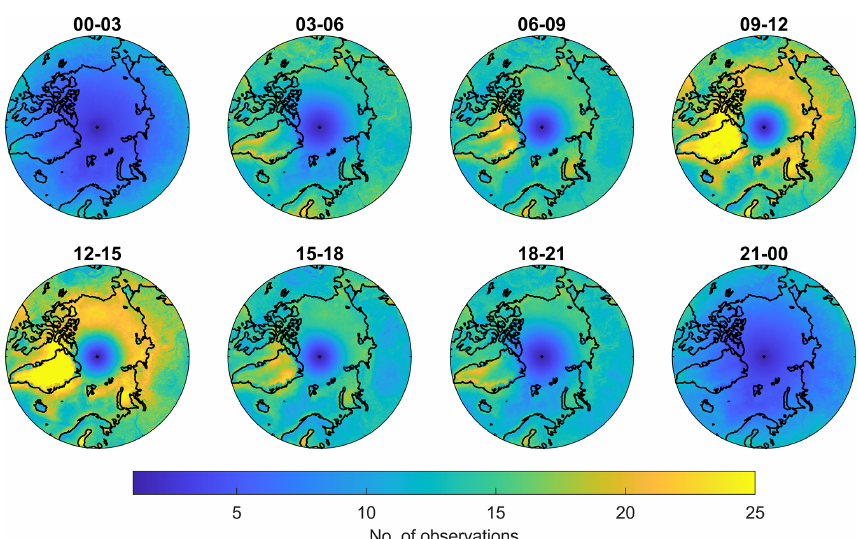
Figure 3. Mean number of observations per day in the L3 bins for each of the eight local solar time intervals, averaged for the period 2000–2009.